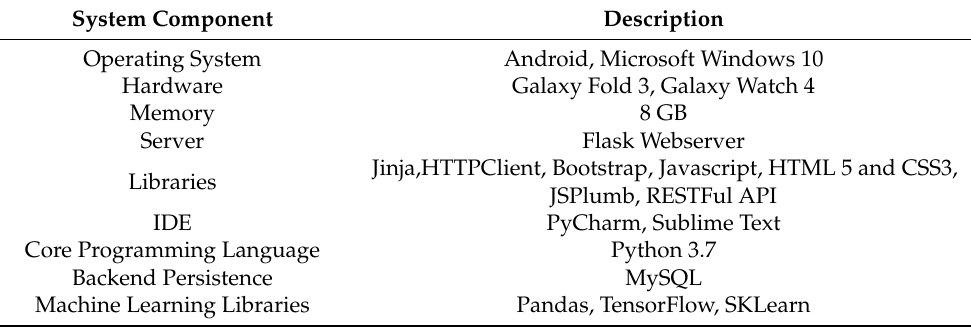
Table 3. Summary of the different modules used in the prototype system.